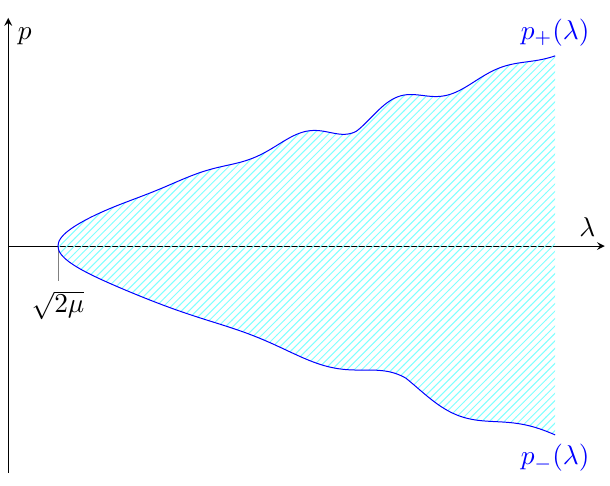
Figure 12 . The low-energy dynamics of N non-relativistic fermions can be described by a (cid:13)uid in phase space. Low-energy excitations above the fermi surface are captured by deformations of the pro(cid:12)le functions p (cid:6) ( (cid:21)